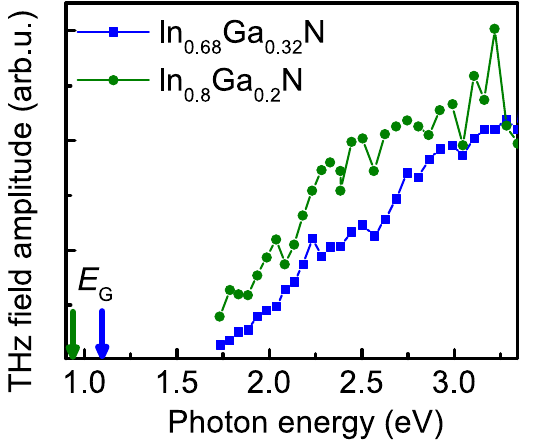
Figure 3. The amplitude of THz field as a function of excitation photon energy in indium-rich In x Ga 1 − x N layers with x = 0.68 (blue symbols) and x = 0.8 (green symbols).